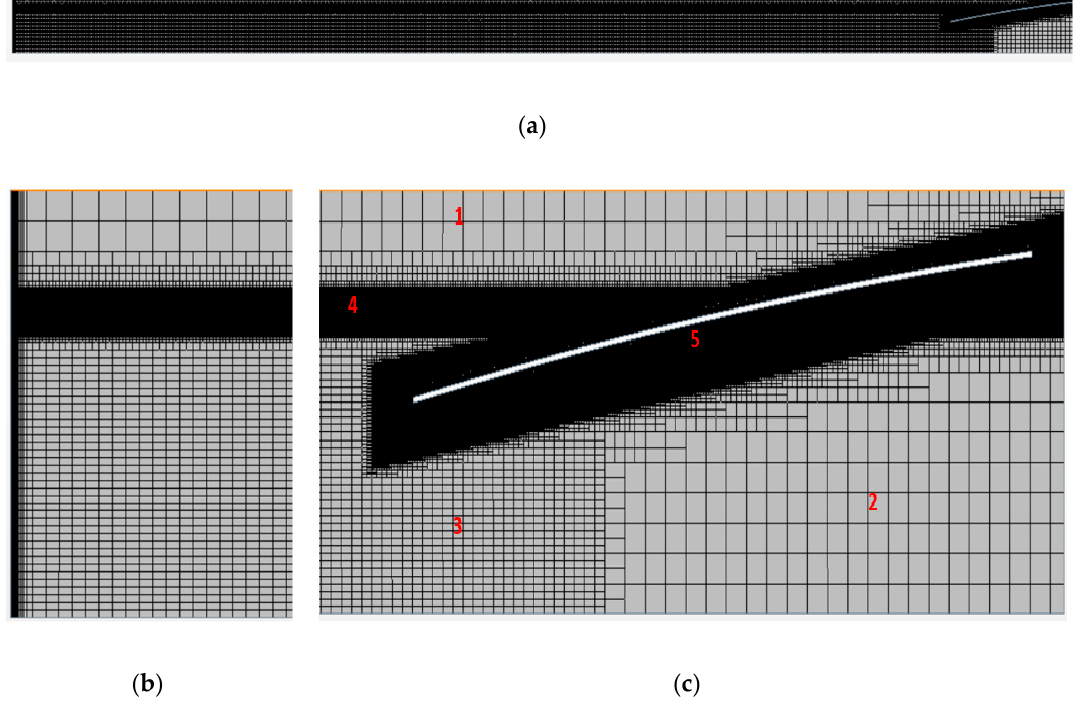
Figure 3. ( a ) Mesh corresponding to a depth of 50 cm, ( b ) focus on the prism layers around the generation paddle. ( c ) The different areas of the mesh: (1) air, (2) below the paddle, (3) “deep-water”, (4) free surface, and (5) extinction system.